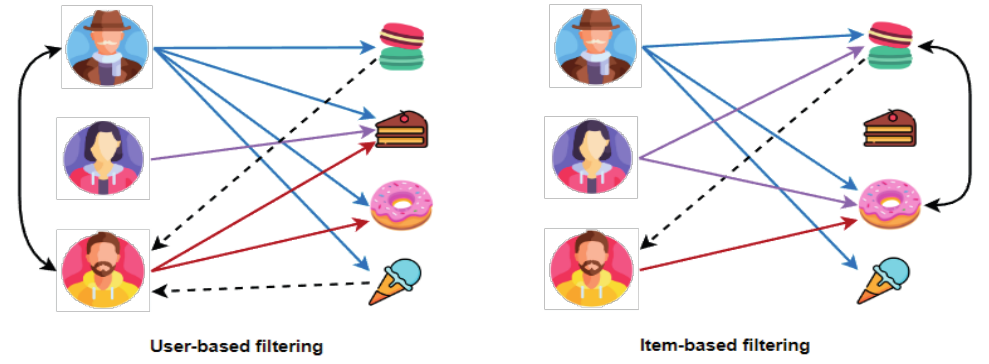
Fig. 2. User-based and item-based collaborative filtering